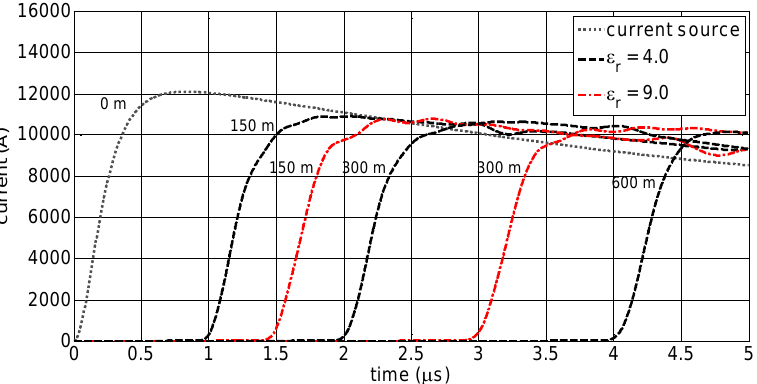
Figure 2. Current distribution along the lightning channel at different height calculated by CST-MWS for relative permittivity 4 and 9. Model A : Wire embedded in a fictitious half-space dielectric media. Table 1. Model A : Wire embedded in a fictitious half-space dielectric media. Computational Time and Memory Resources versus Symmetry Planes for a Relative Permittivity 9.0.